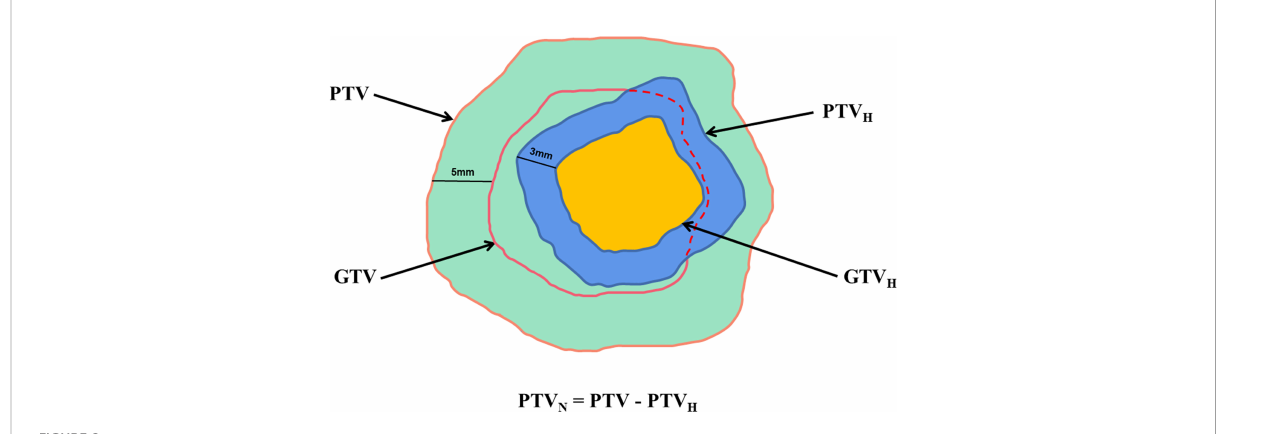
FIGURE 2 Illustration of the target